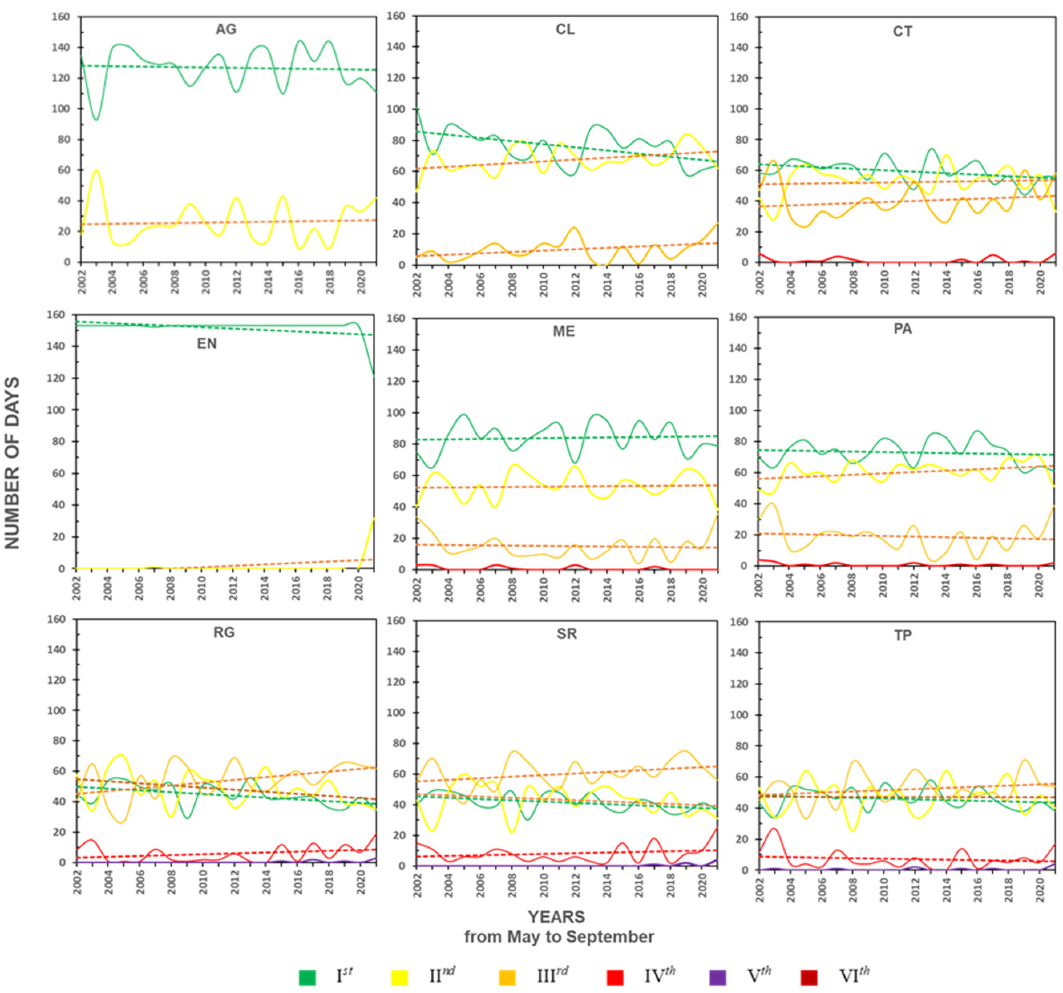
Figure 3. Trend of the number of representative days of each class from 2002 to 2021 (solid line) with regression line (dashed